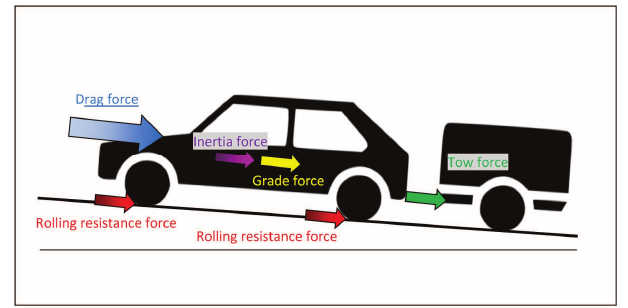
Fig. 1. Resistive forces acting on moving car